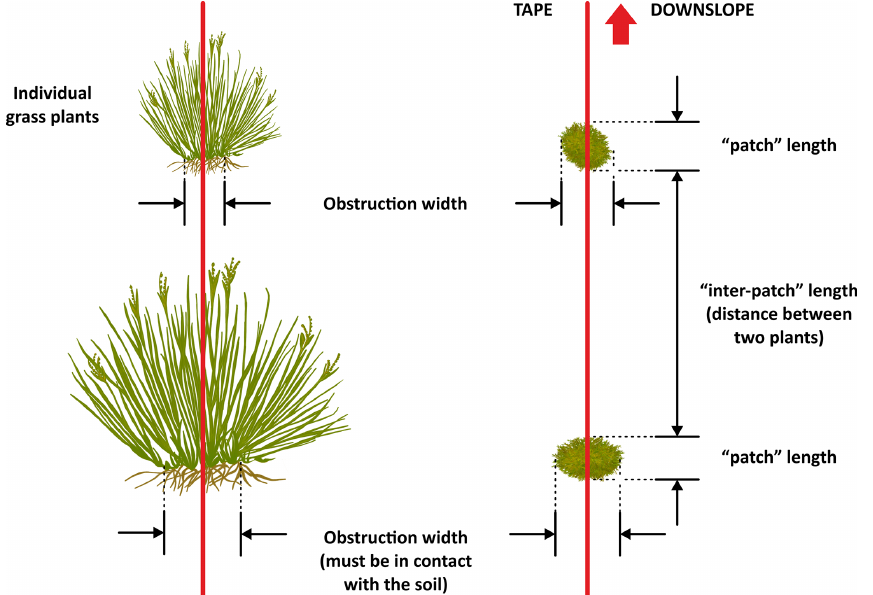
Figure 6. Illustration of how to measure individual grasses when they form the patches on a monitoring transect. Redrawn from Tongway and Hindley